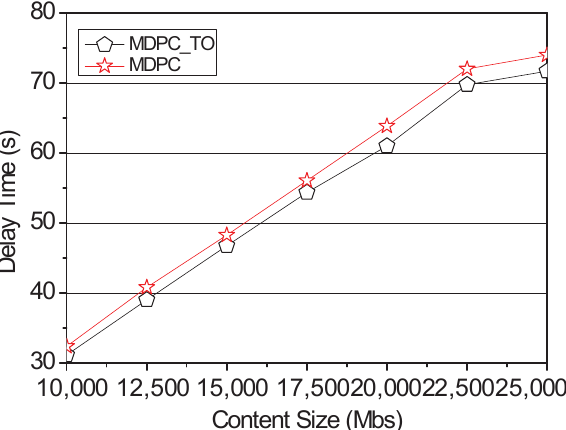
Figure 14. Delay time of optimization according to the content